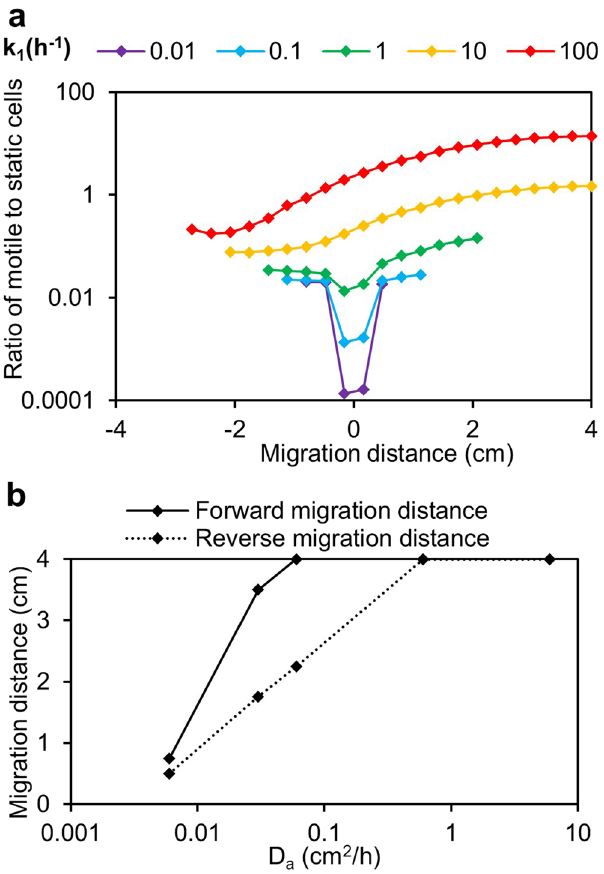
Figure 4. The rate of switching from static to motile ( k 1 ) and the diffusivity of the signal ( D a ) are keys parameters controlling migration of cells: In the simulations, the gradient was established using 85 μ moles/m 2 of the signal near edge of the plate (migration distance = 4 cm). 3.5 * 10 7 static cells/m 2 was used as the inoculum at the centre of the plate (migration distance = 0 cm). ( a ) k 1 was varied from 0.01–100 h − 1 while all other parameters were held constant at values defined in the base parameter set. For each value of k 1 , the ratio of motile to static cells (m/s) across the diameter of the plate (migration distance = − 4 to 4 cm) was plotted after a simulation time of 24 h. The ratio was only calculated at points with a total cell concentration ≥ 10 8 cells/m 2 . ( b ) Simulations were run varying D a from 0.01 − 10 cm 2 /h while holding all other parameters constant. Forward and reverse migration distances were measured as distances from the inoculation point (migration distance = 0) towards and away from the signal source at which a total cell concentration ≥ 10 8 cells/m 2 was observed after a simulation time of 24